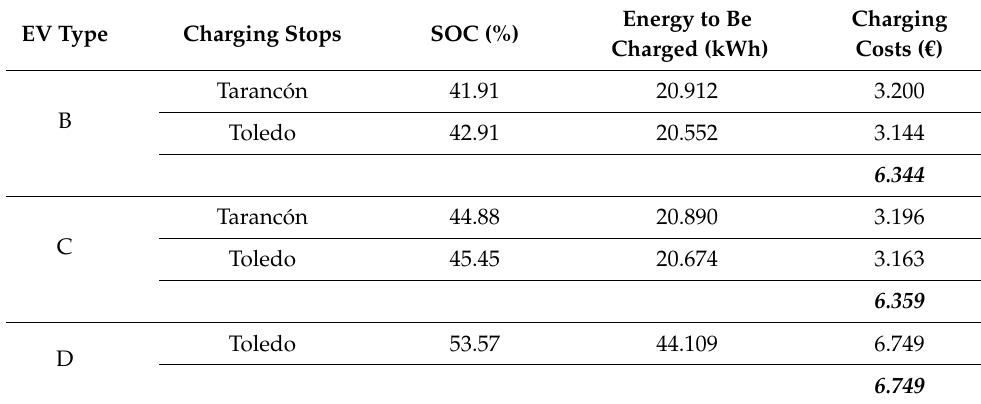
Table 6. Simulation results for the Cuenca–Toledo